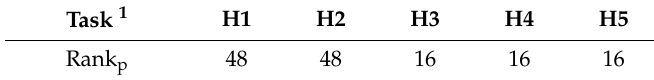
Table 16. Task Rank p of tasks in Hilbert transforms.